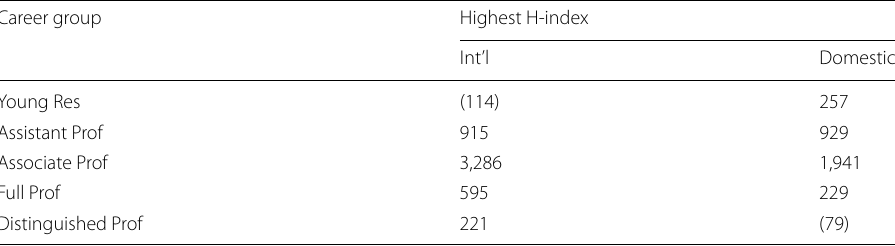
A class is considered representative if there are at least 150 samples. We wrap within parentheses classes with too few samples